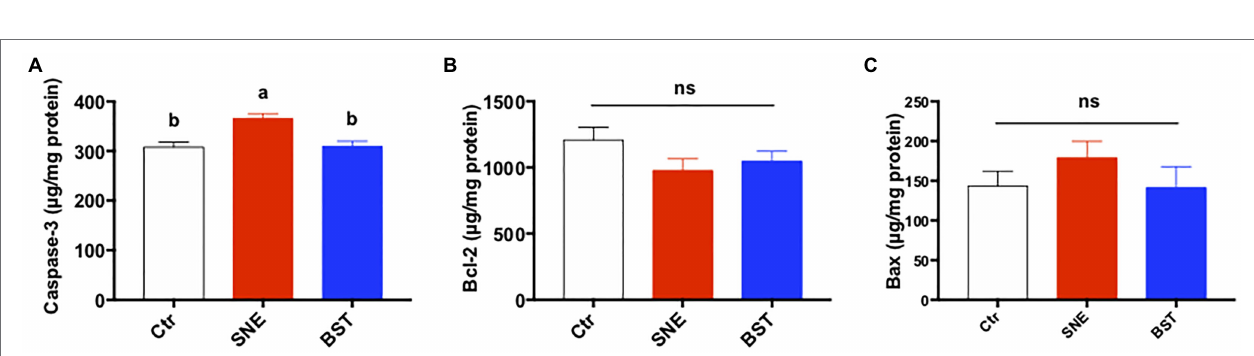
FIGURE 3 | Cytokine levels in the jejunum. Bars with different letters significantly differ on the basis of Turkey’s multiple range tests ( p < 0.05). Data are presented as mean ± SEM ( n = 8). sIgA, secretory IgA; TNF- α , tumor necrosis factor-alpha; IFN- γ , interferon-gamma. Ctr group, basal diet in control group; SNE group, basal diet + SNE (20-fold dose coccidiosis vaccine) + 1 ml of Clostridium perfringens (2 × 10 8 cfu/ml coinfection); BST group, basal diet (days 1–21) + 1 × 10 9 colony-forming units (cfu)/kg BS diet (days 22–63) +